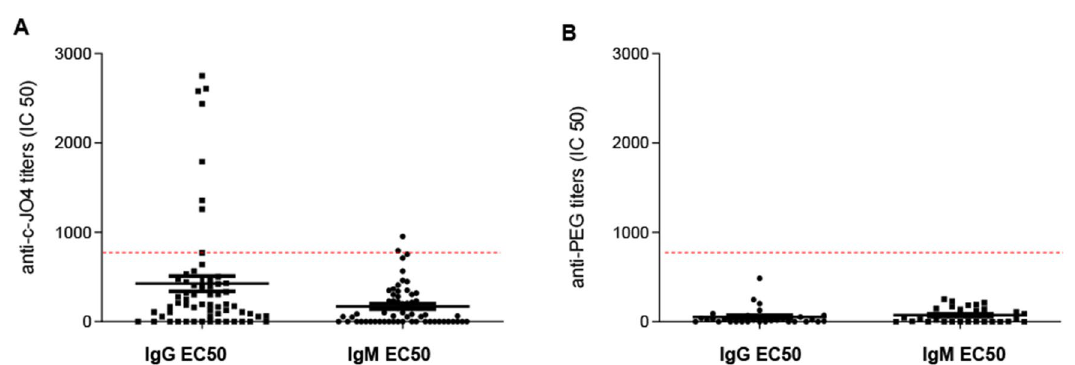
Figure 7. Serum antibodies against c-JO4 and PEG/Doxil in ovarian cancer patients A titer below 1:800 is not neutralizing in in vitro infection studies. Serum samples from the Fred Hutchinson Cancer Research Center was taken for analysis of antibodies against ( A ) c-JO4 ( B ) PEG/Doxil using anti-Ad3 and anti-PEG antibodies respectively in an ELISA. EC50 values are